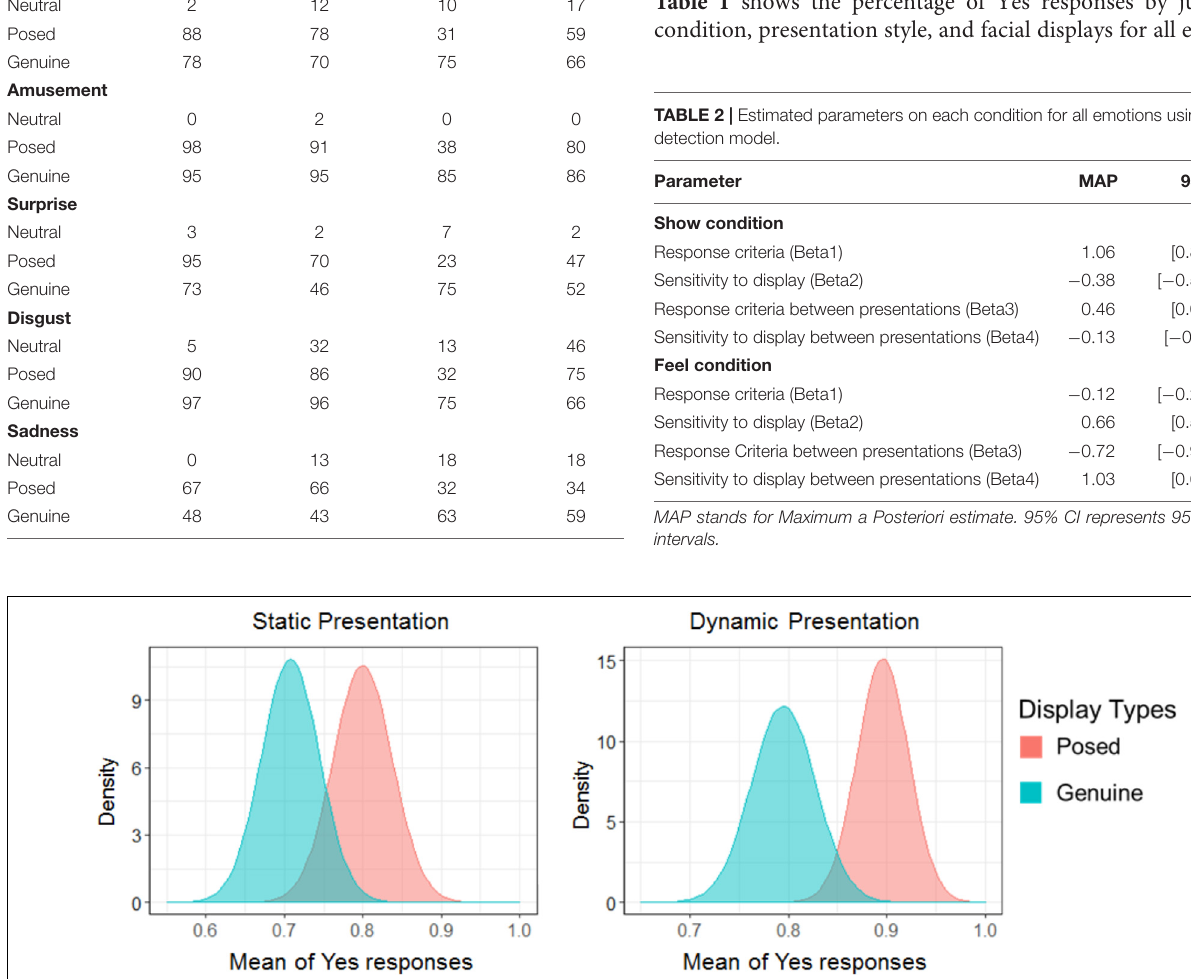
Frontiers in Psychology |